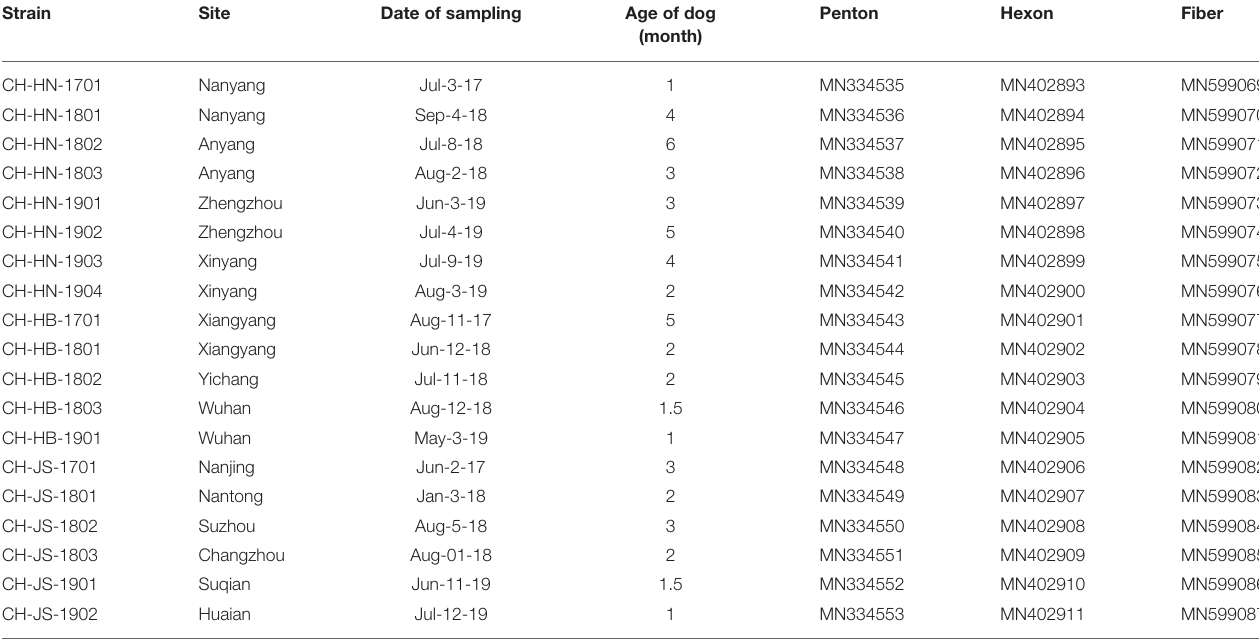
TABLE 3 | Relative information of the CAdV-2 strains identified in China in this study. Strain Site Date of sampling Age of dog